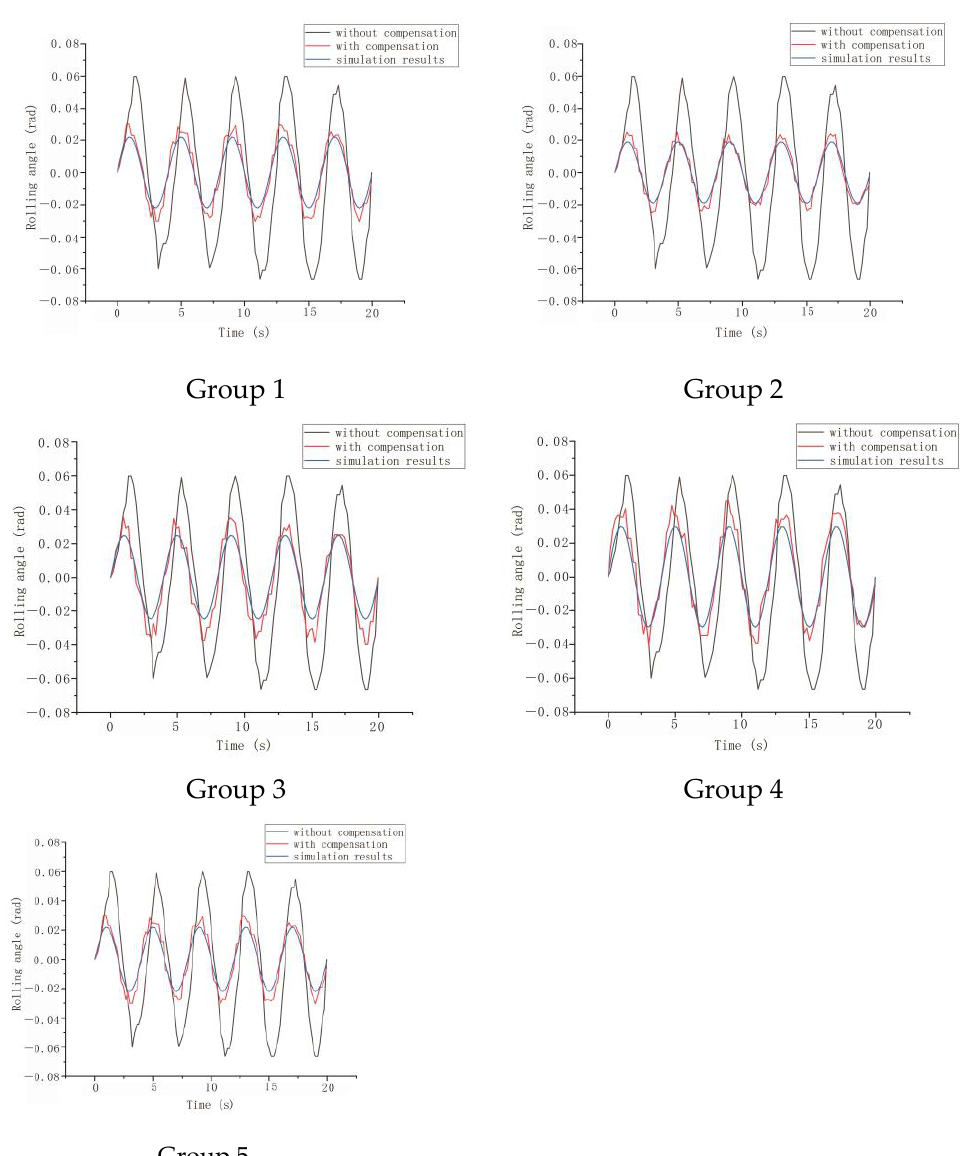
Figure 13. Simulation results in third-level sea state. Similarly, the simulation of a level four sea state and level five sea state is carried out. The third group of PID parameters (570, 76, 5.4, respectively) has the best compensation effect in quaternary sea condition. In class five sea conditions, the PID parameters of the fourth group (440, 71, 5.4, respectively) are selected to achieve the best compensation effi- ciency.